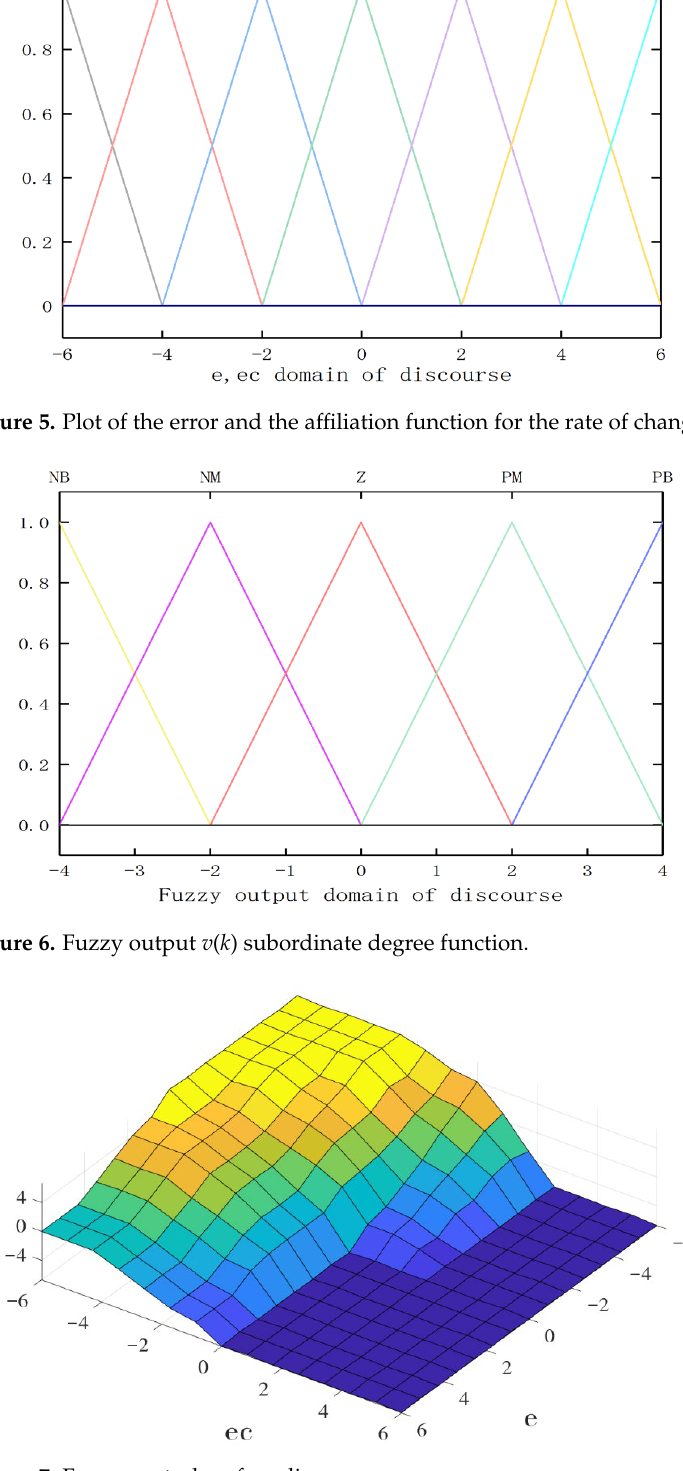
Figure 7. Fuzzy control surface diagram.